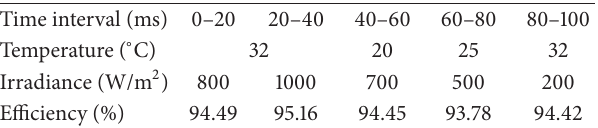
Table 6: Efficiency obtained for the P&O technique under distinct operating